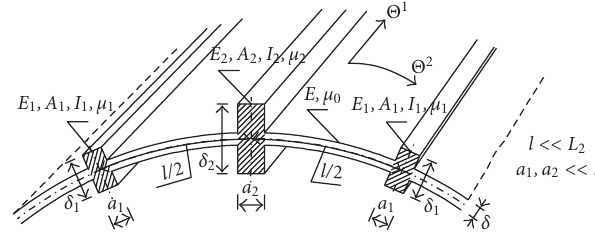
Figure 6.2. A fragment of the sti ff ened shell